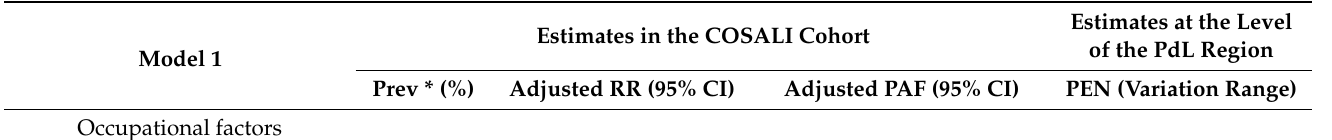
Table 2. Proportion and population estimated number (PEN) of incident UEMSDs attributable to exposure to occupational risk factors in the working population in the PdL